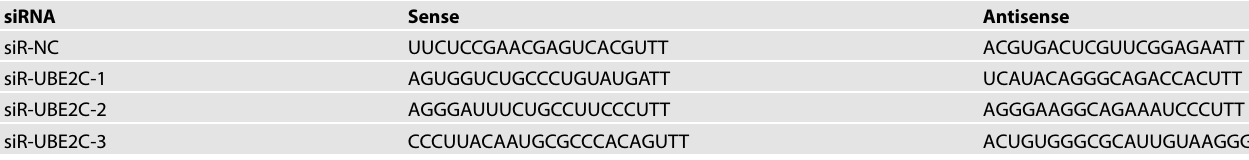
Table 4. Three differential small interfering RNA sequences for UBE2C knockdown.